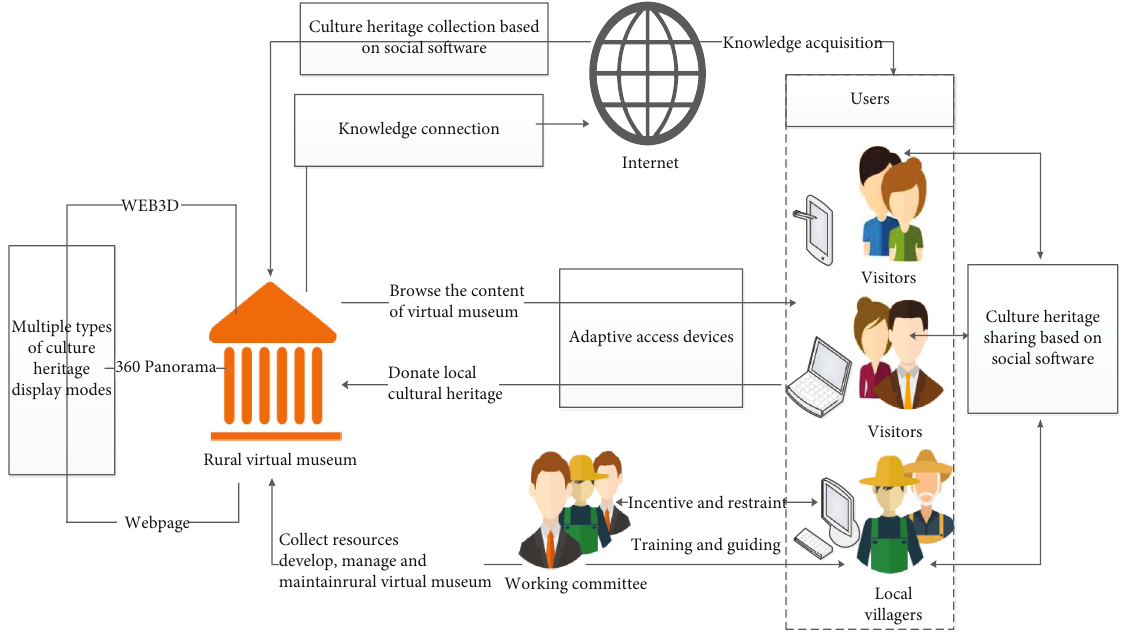
Figure 1: The operation framework of rural cultural heritage